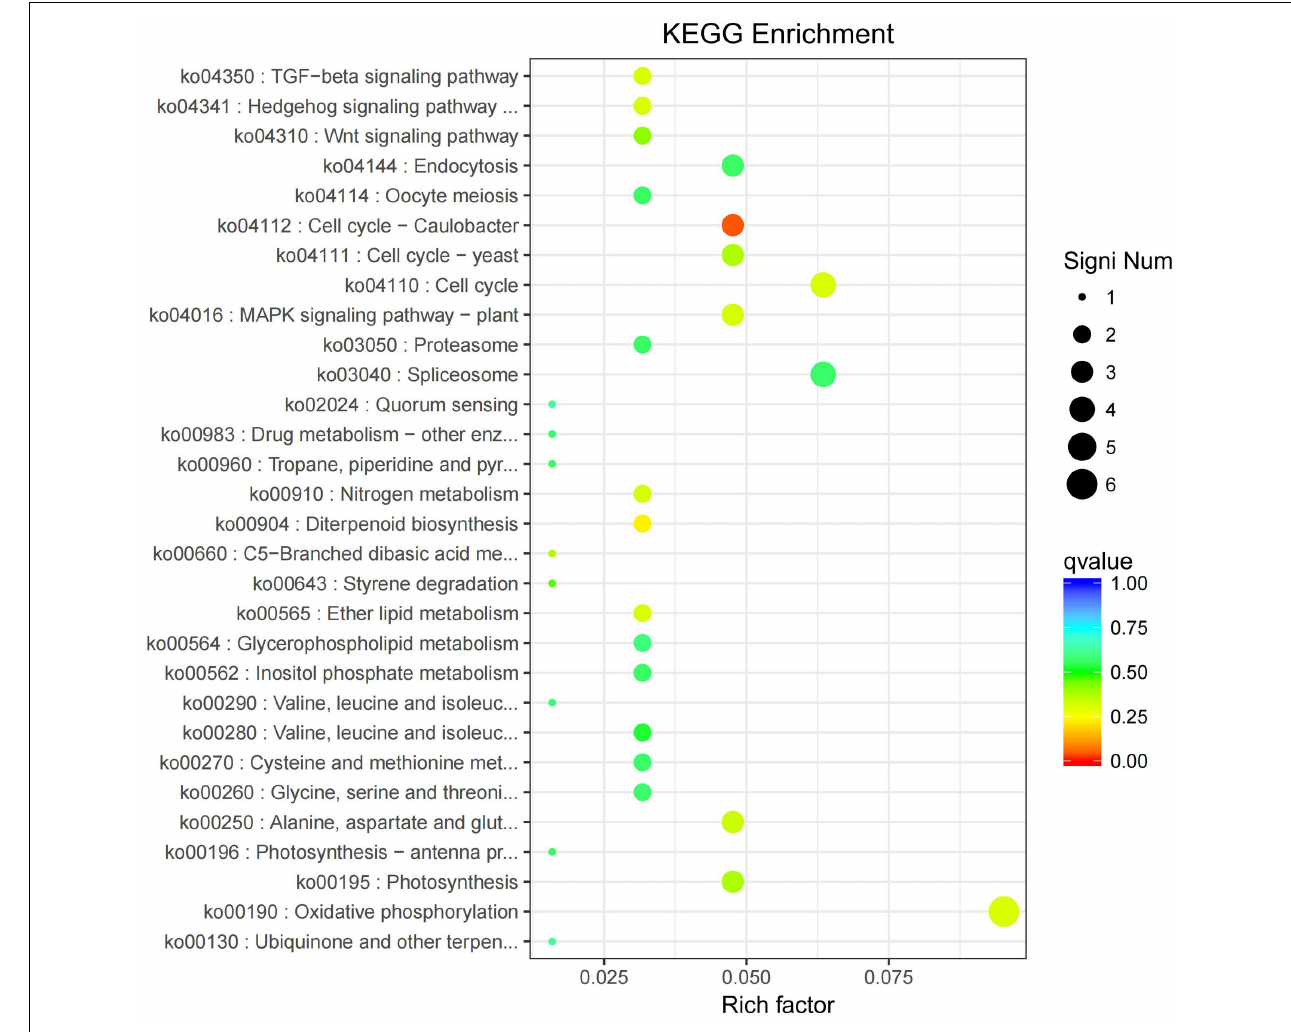
FIGURE 7 | KEGG pathway enrichment of differentially expressed genes (DEGs) in the leaves of Cyclocarya paliurus between low and high